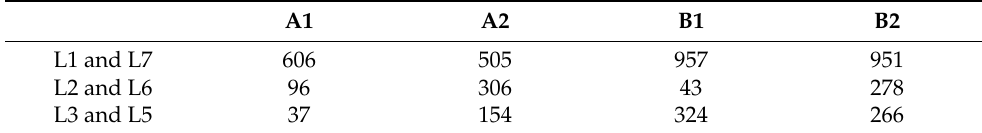
Table 3. Optimized number of neurons in intermediate layers for the four